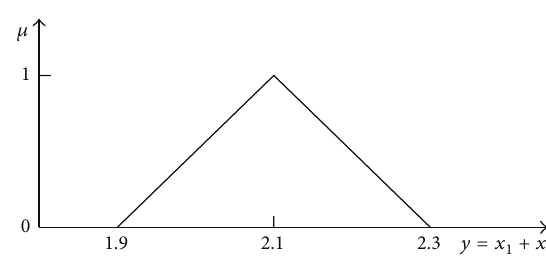
Figure 11: 2D representation of the full 4D addition result obtained with formulas (45) and (46) corresponding to the “result” obtained with Zadeh’s extension principle (34).